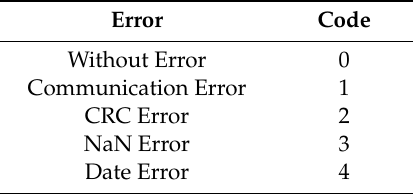
Table 1. Error table that can be identified in the Data Acquisition step.